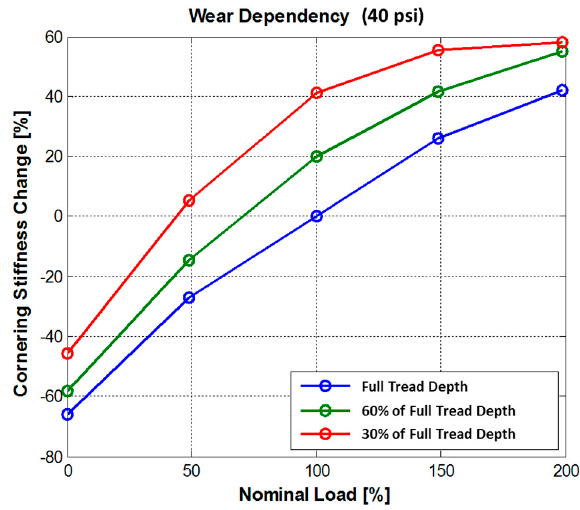
Figure 11. Wear dependency effects under constant inflation pressure conditions.